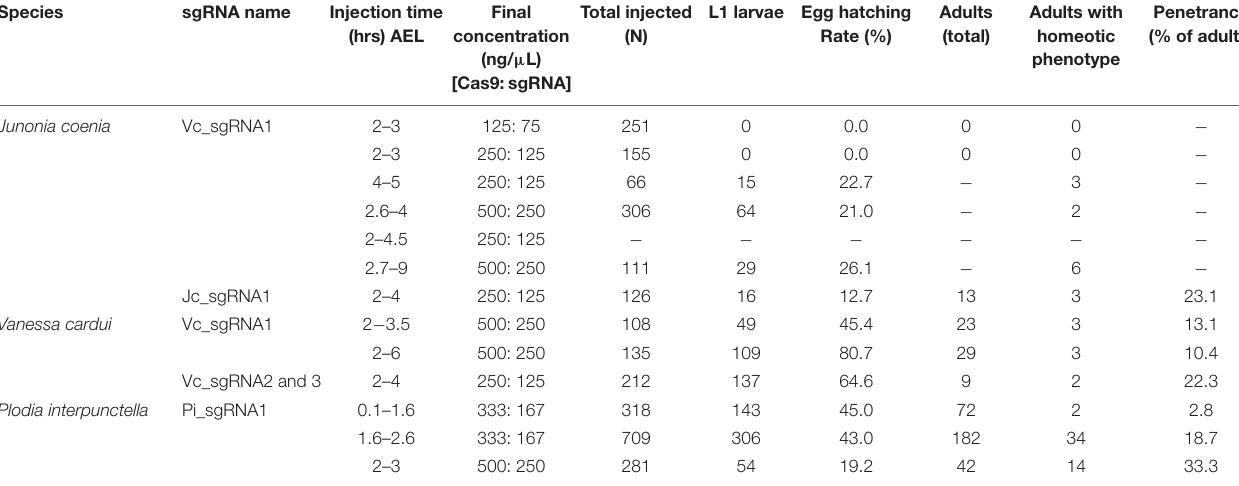
TABLE 1 | Summary of CRISPR/Cas9 injection experiments.